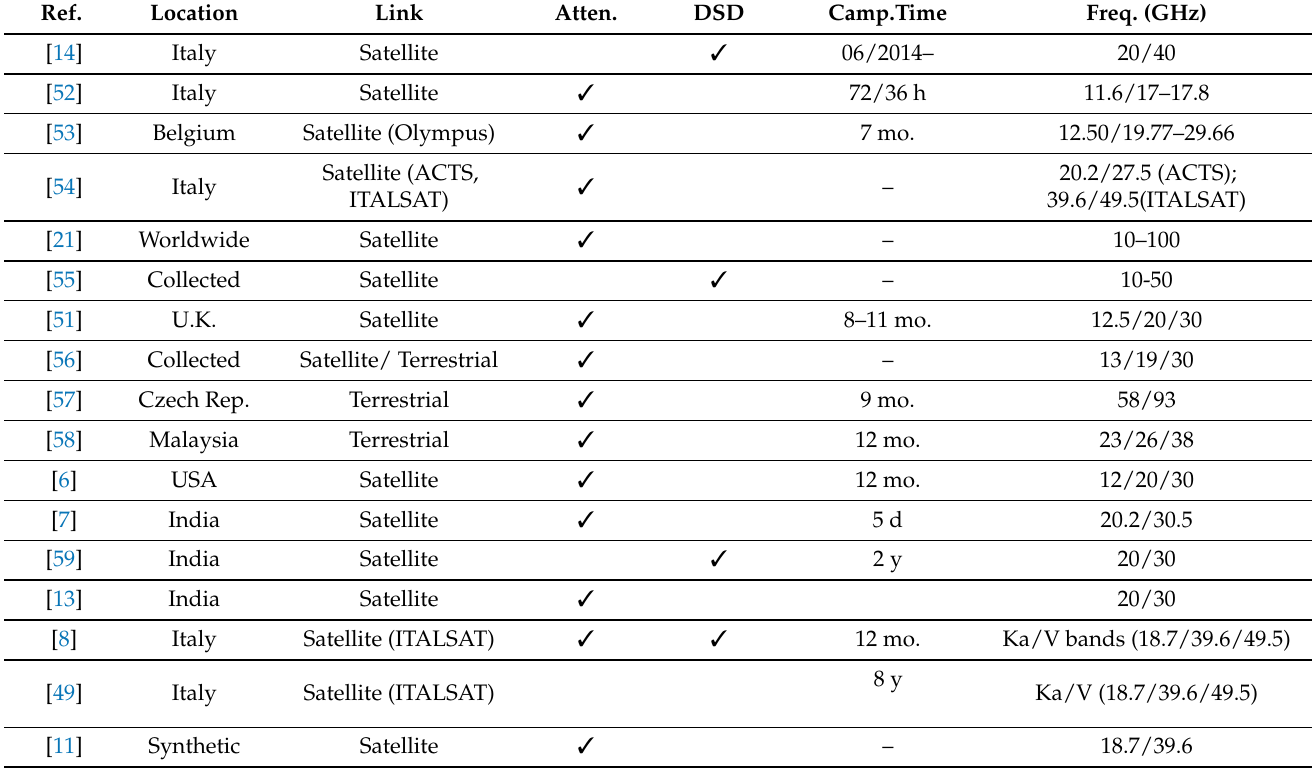
Table 1. Comparison among the scaling of propagation